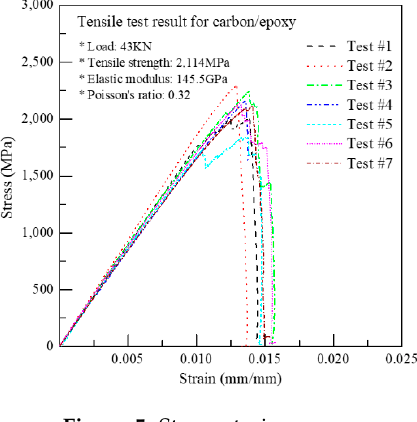
Figure 5. Stress-strain curve.